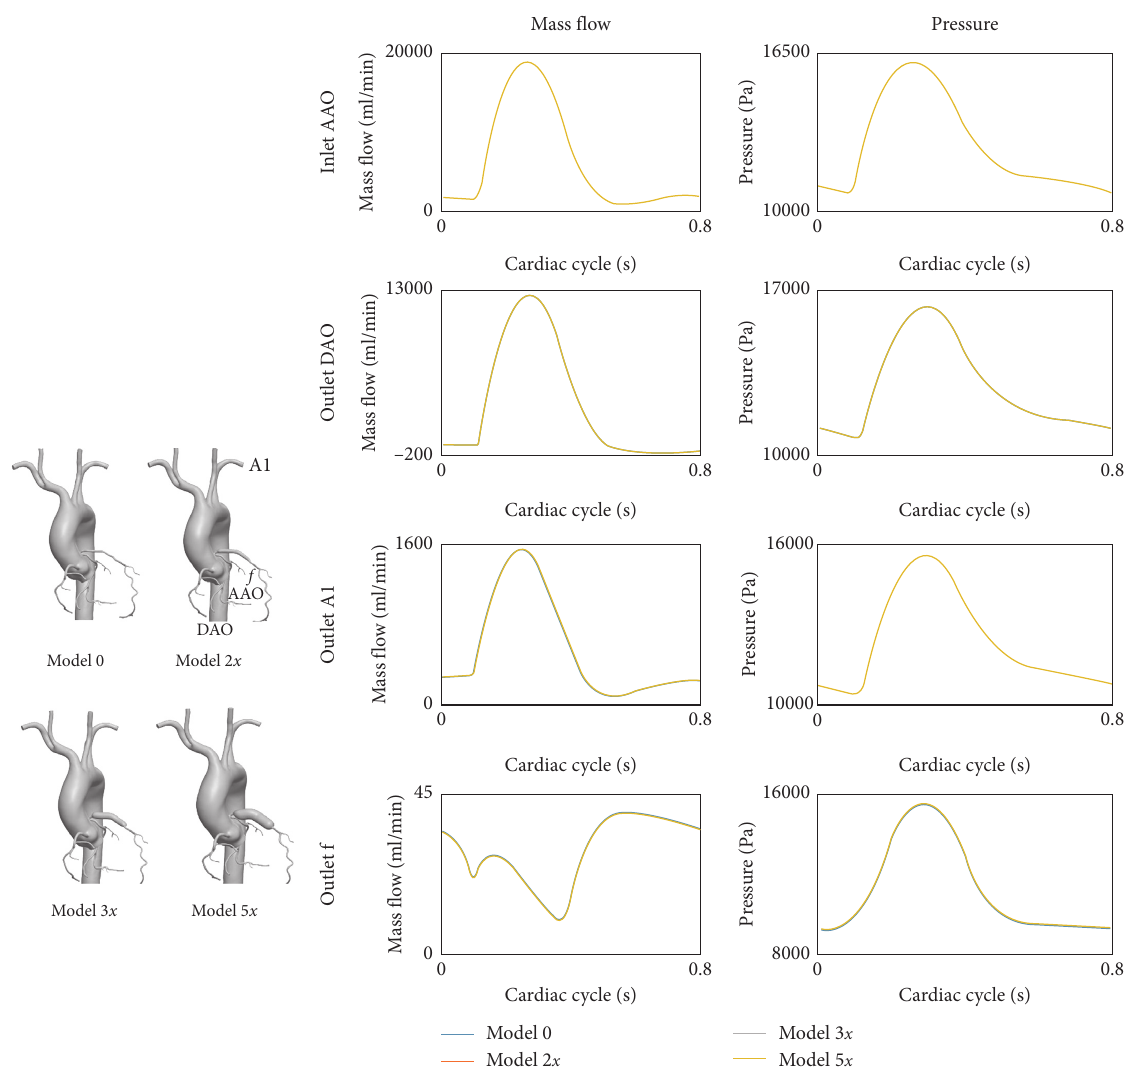
Figure 4: Mass flow and pressure curves for the inlet (ascending aorta, AAO) and three outlets (descending aorta (DAO), artery 1 (A1), and coronary artery f ) over a cardiac